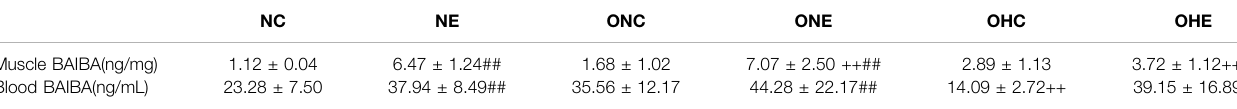
TABLE 4 | Levels of BAIBA in Gastrocnemius Muscle and Blood of Rats after normoxic and hypoxic exercise ( n = 8). NC NE ONC ONE OHE Muscle BAIBA(ng/mg)